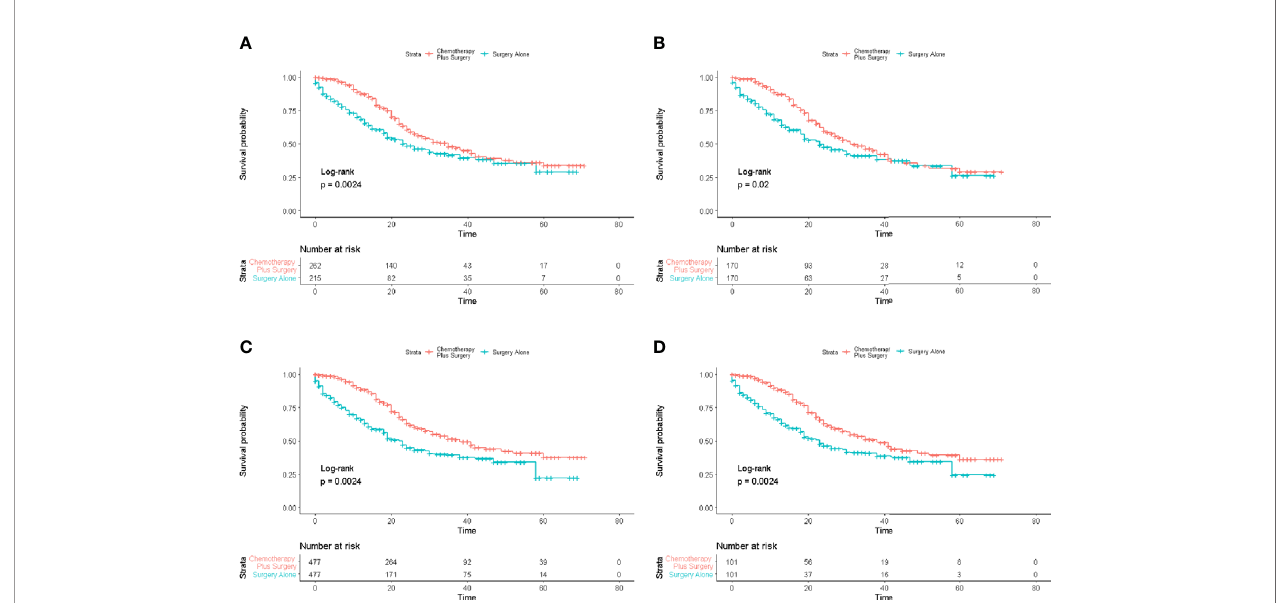
FIGURE 2 | Survival analysis of overall survival (OS) for patients with limited-stage SCLC receiving chemotherapy-plus-surgery or surgery-alone treatment. (A) Kaplan-Meier analysis of OS before matching; (B) Kaplan-Meier analysis of OS after matching; (C) Kaplan-Meier analysis of OS after IPTW analysis; (D) Kaplan-Meier analysis of OS after Overlap Weighting